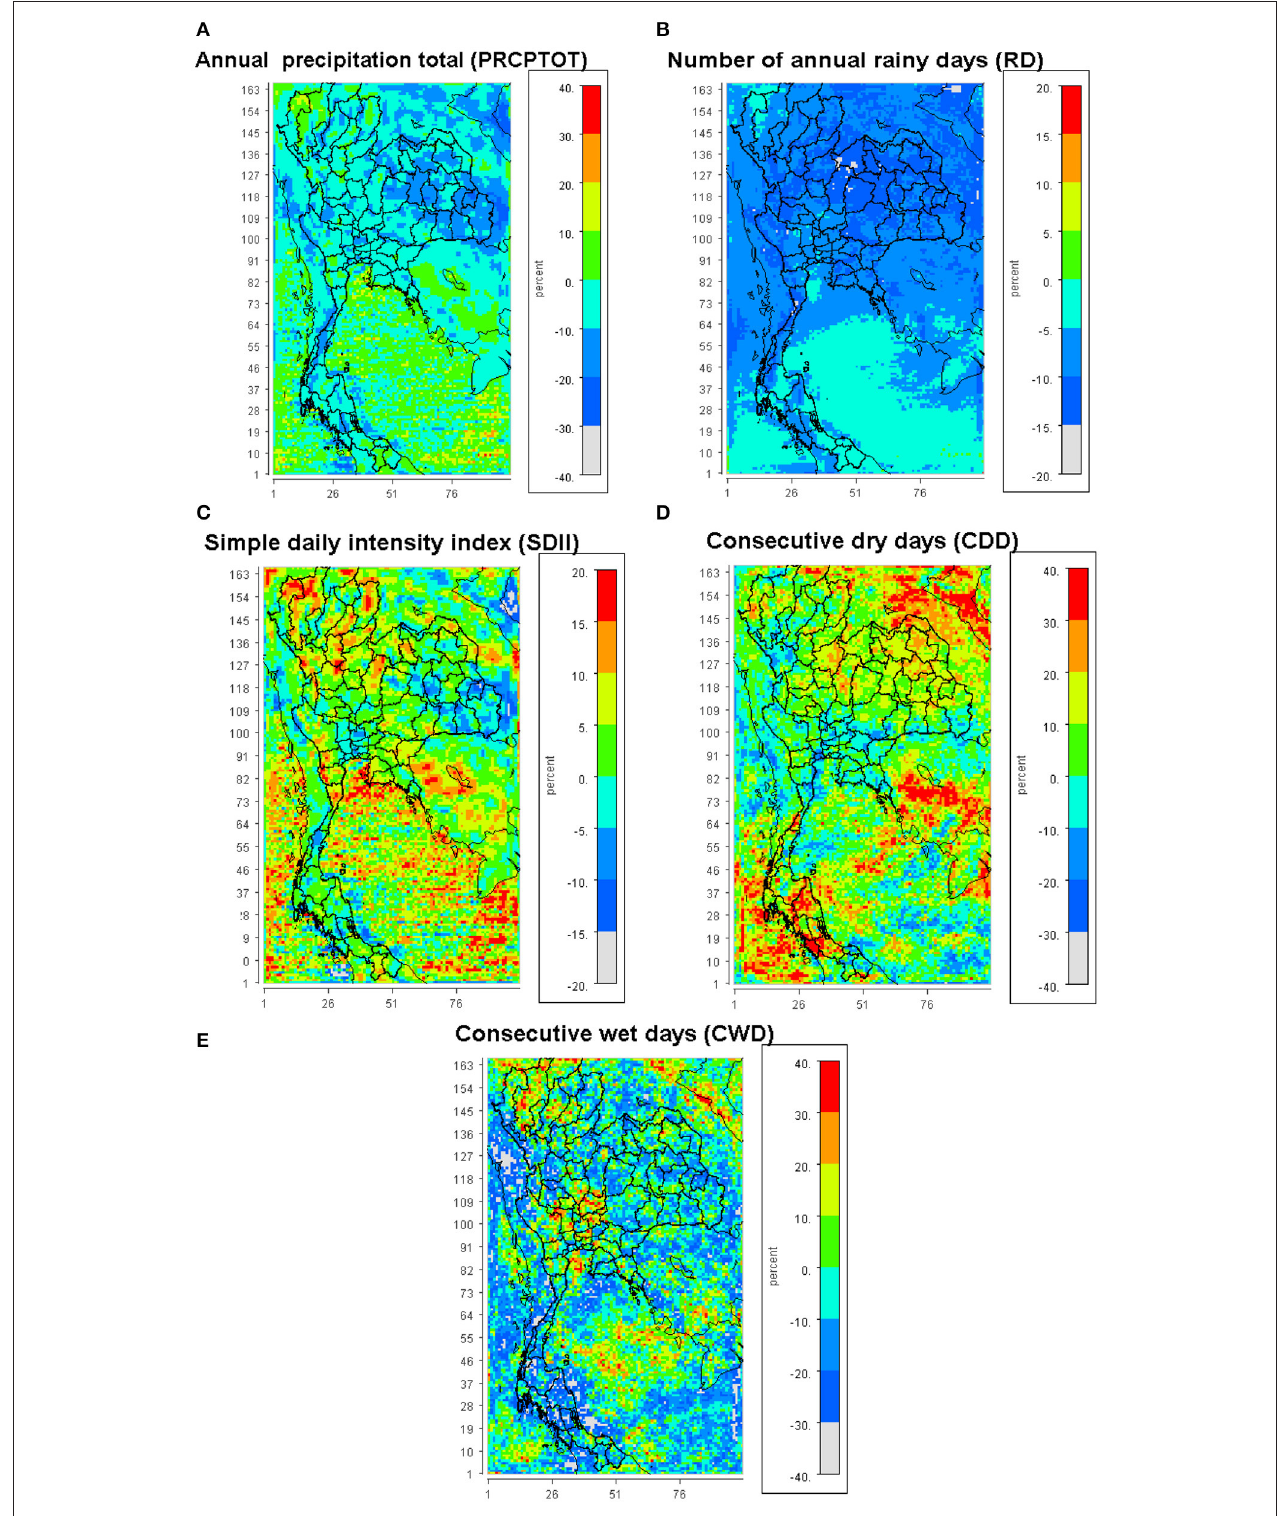
FIGURE 1 | Spatial distribution of percentage differences in (A) PRCPTOT, (B) RD, (C) SDII, (D) CDD, and (E) CWD between years 2020 and 2029 and between years 1990 and 1999 in Thailand.